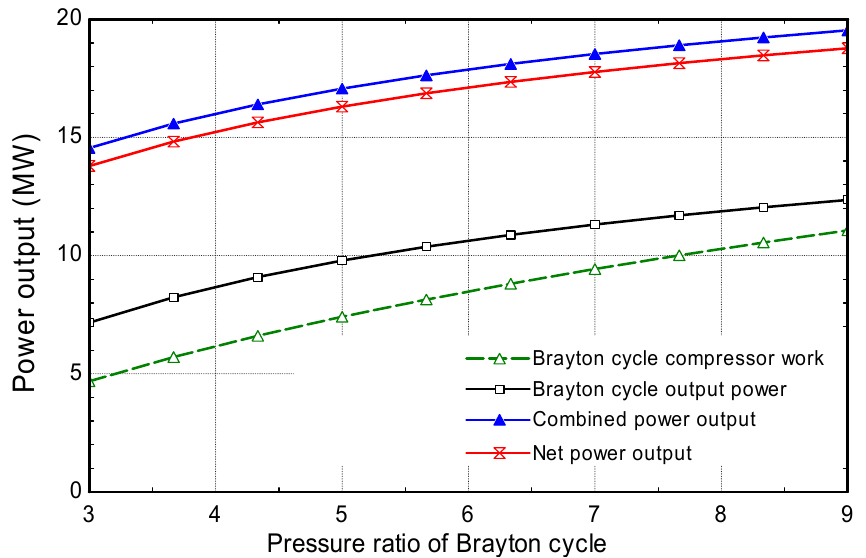
Figure 2. Impact of varying the pressure ratio of the Brayton cycle on the compressor work and power output.